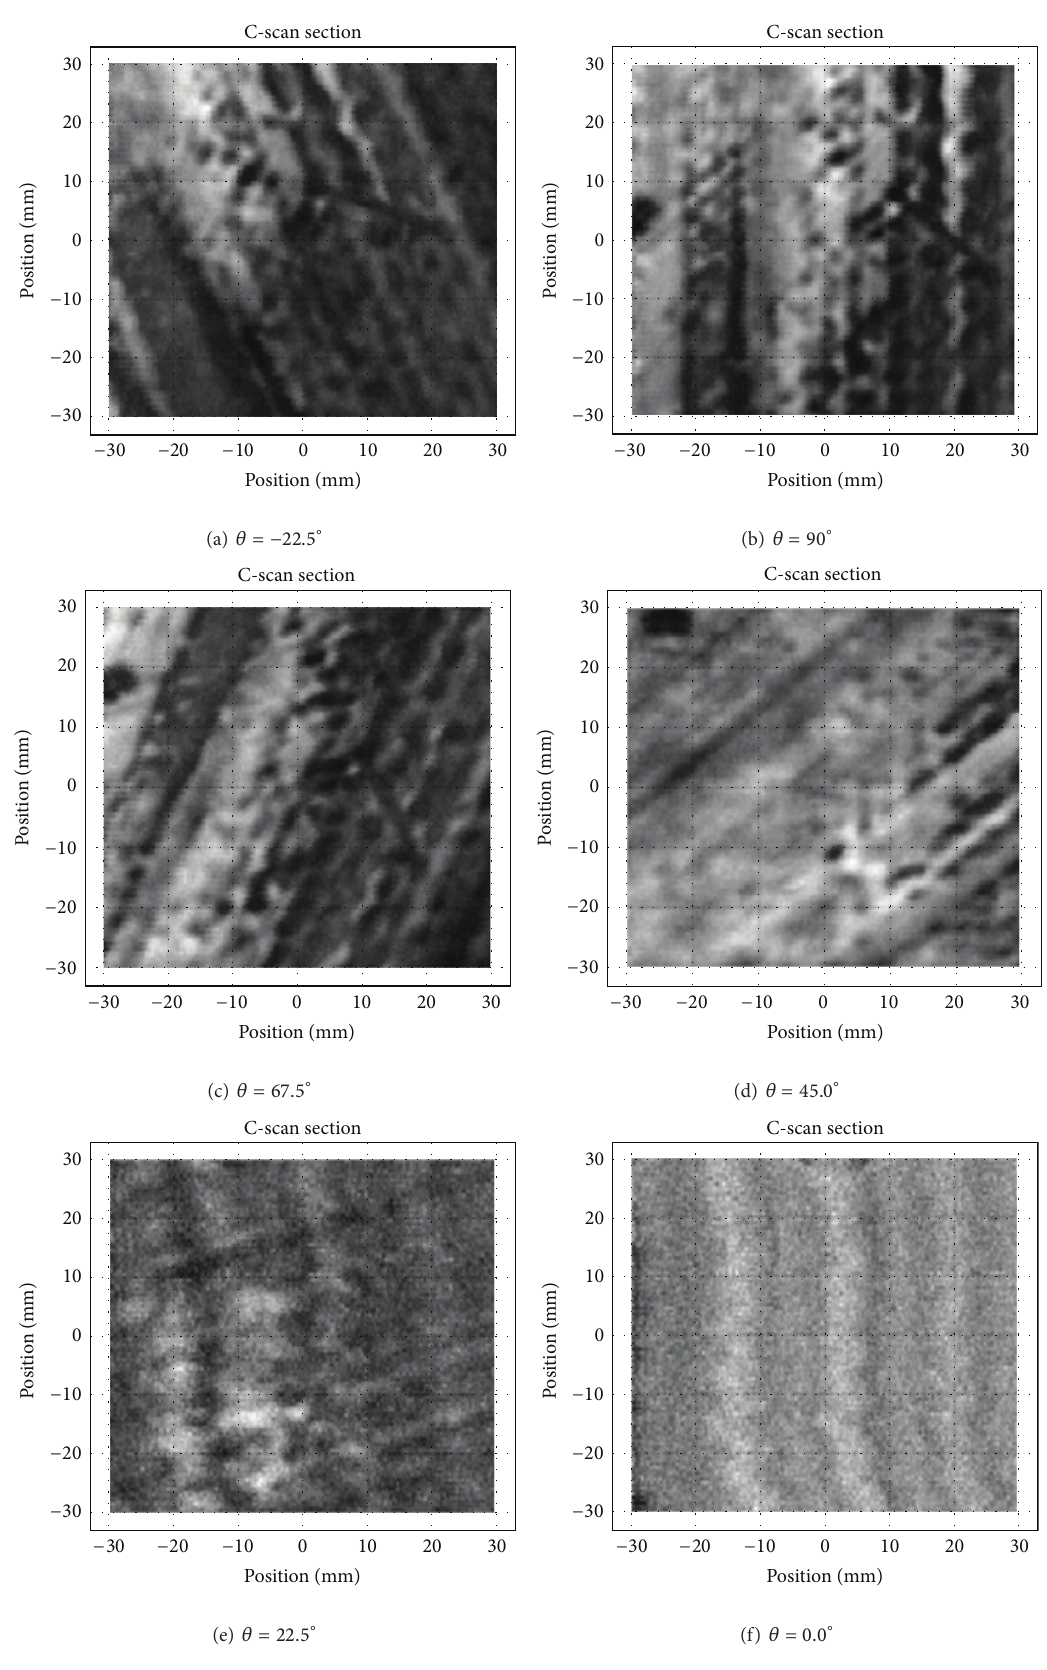
Figure 13: Diagram showing TDS scan images at the angles ( 𝜃 ) of − 0 ∘ , − 45 ∘ , 90 ∘ , and 0 ∘